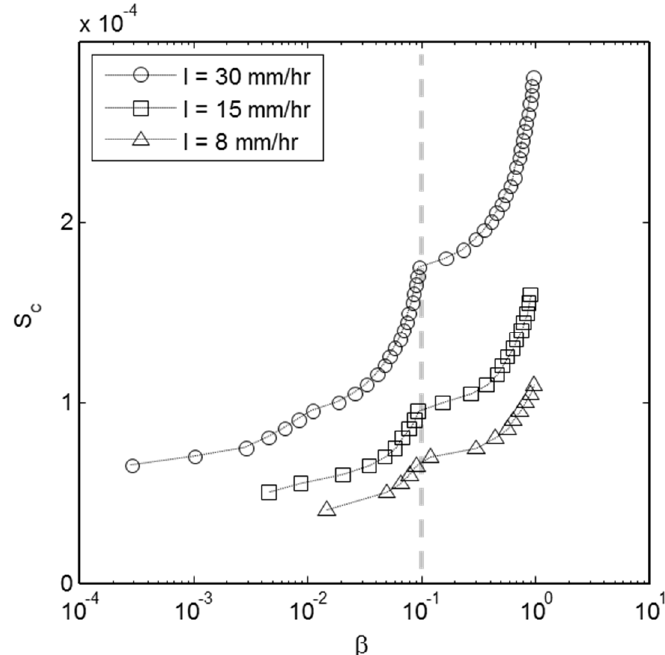
Figure 7. Behavior of the peak flow of a fully looped network depending on the catchment slope and rainfall intensity.